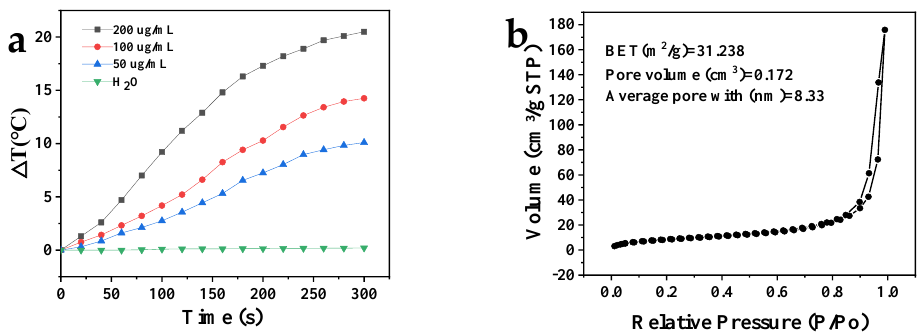
Figure 7. ( a ) Temperature variation of nanoparticle solutions containing different concentrations of MPDA. ( b ) N 2 adsorption and desorption curves of MPDA. BET, MPDA. ( b ) N 2 adsorption and desorption curves of MPDA. BET, Brunauer – Emmett – Teller.